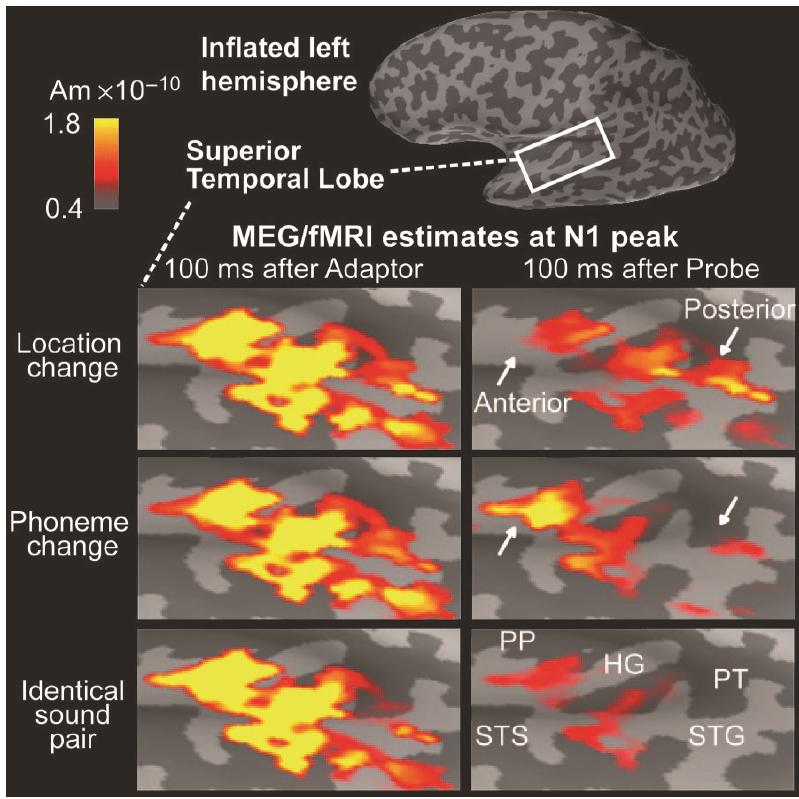
Figure 10. Task-modulated distributed source estimates in the auditory cortex. Distributed functional magnetic resonance imaging (fMRI)-weighted cortical source estimates at auditory cortex marked by the rectangle in the inflated cortical view (top). Source estimates depicted at 100 ms after the adaptor stimulus (left column) and after the probe stimulus (right column). The three rows show the different adaptor-probe combinations. See the text for details. PP = Planum Polare, HG = Heschl’s Gyrus, PT = Planum Temporale, STS = Superior Temporal Sulcus, STG = Superior Temporal Gyrus.